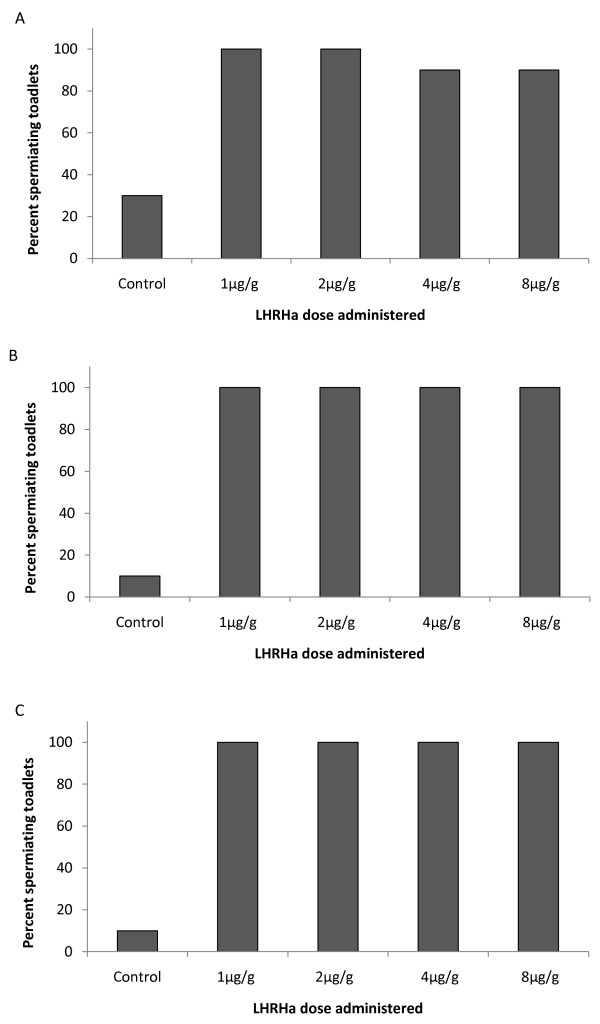
Number of spermiating toadlets. The percentage of males releasing sperm at A) 3 h, B) 7 h and C) 12 h PA.